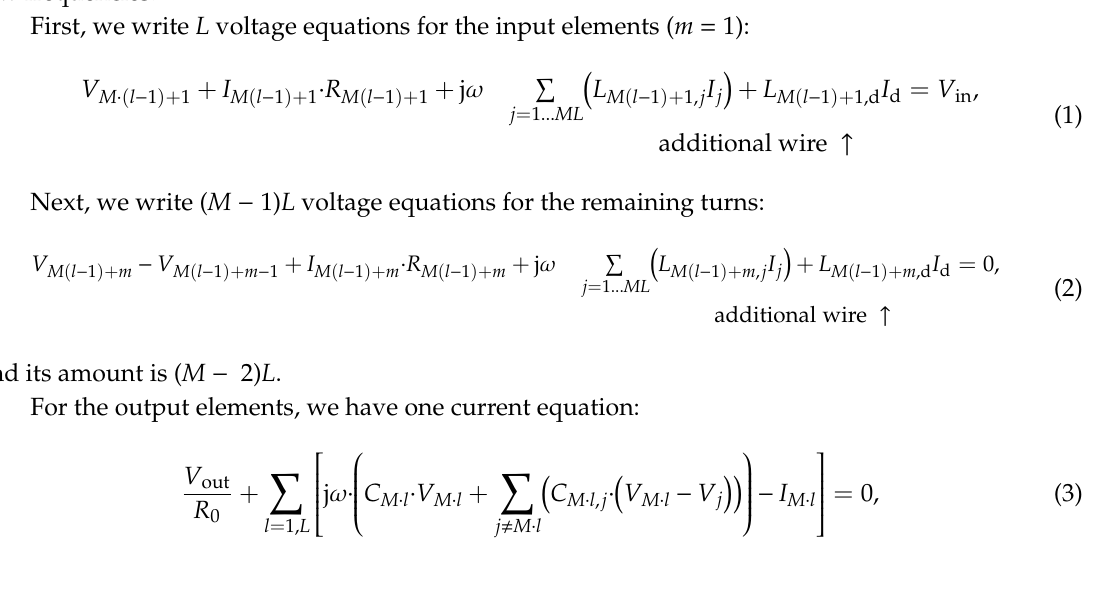
Figure 4. Additional wire representing other windings of transformer with the bushings’ capacitance. The additional wire, denoted by subscript d, contains its inductance, resistance, capacitance to the ground, the bushings’ capacitance, and the inductive coupling to other wires. The capacitances to other wires were neglected because the influence of this wire on the FR curve can only be seen for low